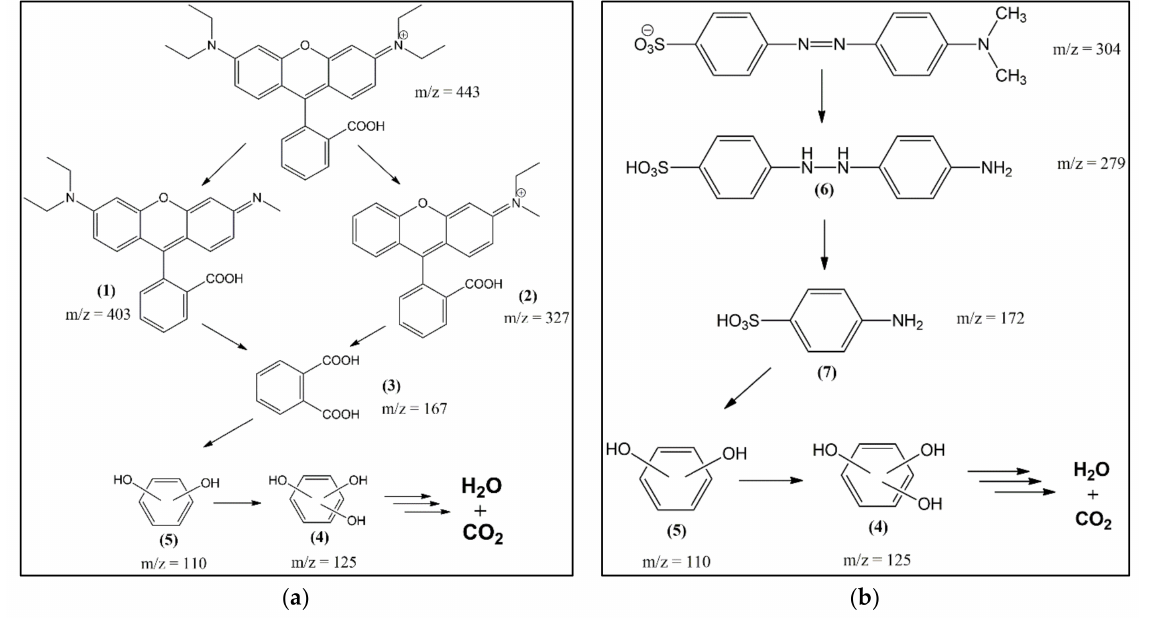
Figure 11. Schematic illustration of the proposed degradation pathway of: ( a ) rhodamine B; and ( b ) methyl orange.